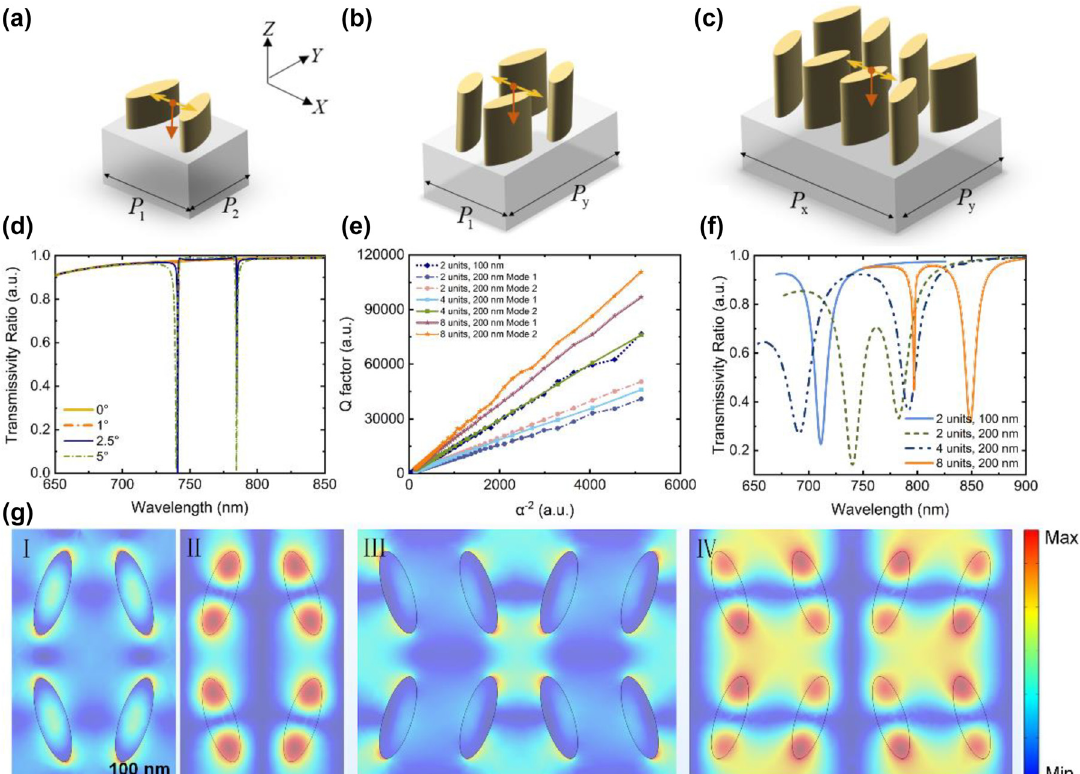
Figure 3: The corresponding transmission spectra and electric fields of metasurfaces with different nanopillar arrangements. (a)–(c) Illustrations of three arrangements of nanopillars, with 2, 4 and 8 elliptical nanopillar units arranged in one period. P The transmission spectra of metasurfaces composed of two 200-nm-height nanopillars in one period, with 𝜃 of 0 ◦ , 1 ◦ , 2.5 ◦ , and 5 ◦ , respectively. (e) The dependence of the Q factor on 𝛼 in four metasurfaces. The nanopillars are considered ideally lossless in (d) and (e), and 𝛼 is the sine of 𝜃 . (f) Transmission spectra of the four metasurfaces when considering the material loss. (g) The electric field maps of the two eigenmodes for